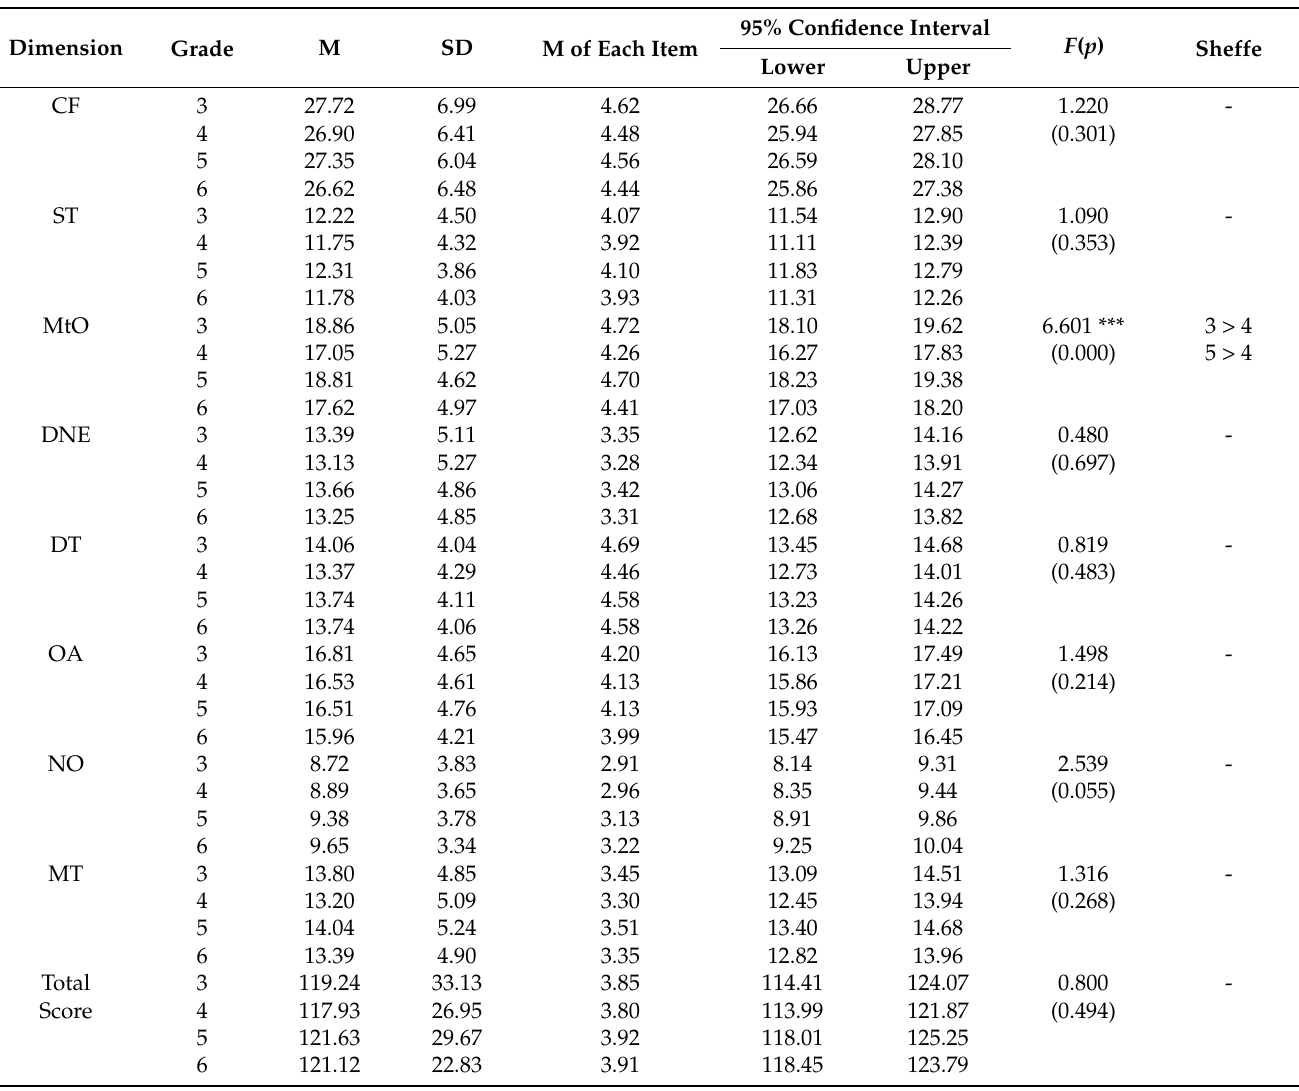
Table 6. The difference in constructive thinking by